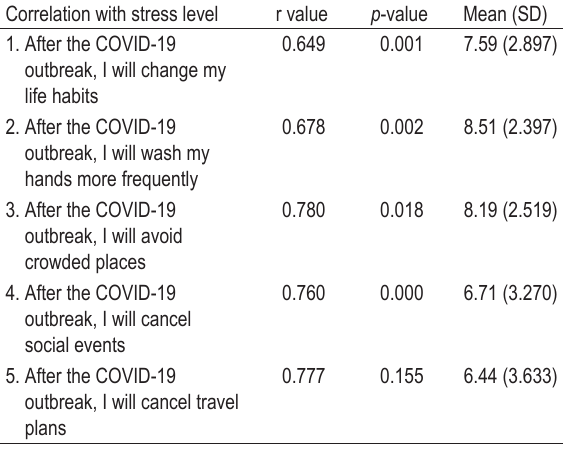
TABLE 4. Association between change in behaviors due to COVID‑19 and stresses, worries, COVID‑19 fatality rate, and training